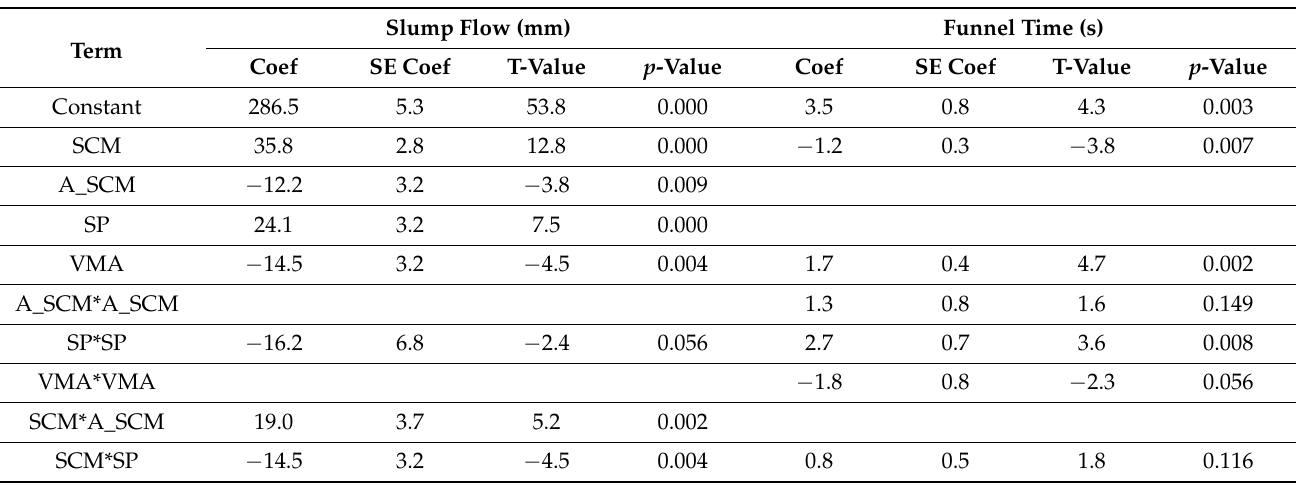
Table 6. Regression coefficients, standard error of the coefficients, T-values, and p -values of the factors affecting slump flow and funnel